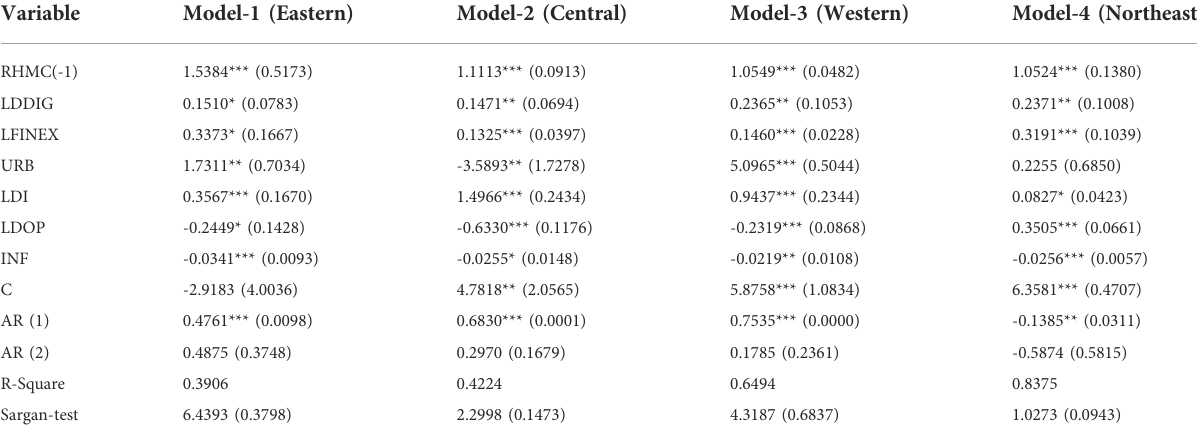
TABLE 10 Results of systematic GMM estimation of the effect of depth of use on rural human capital accumulation in different regions.